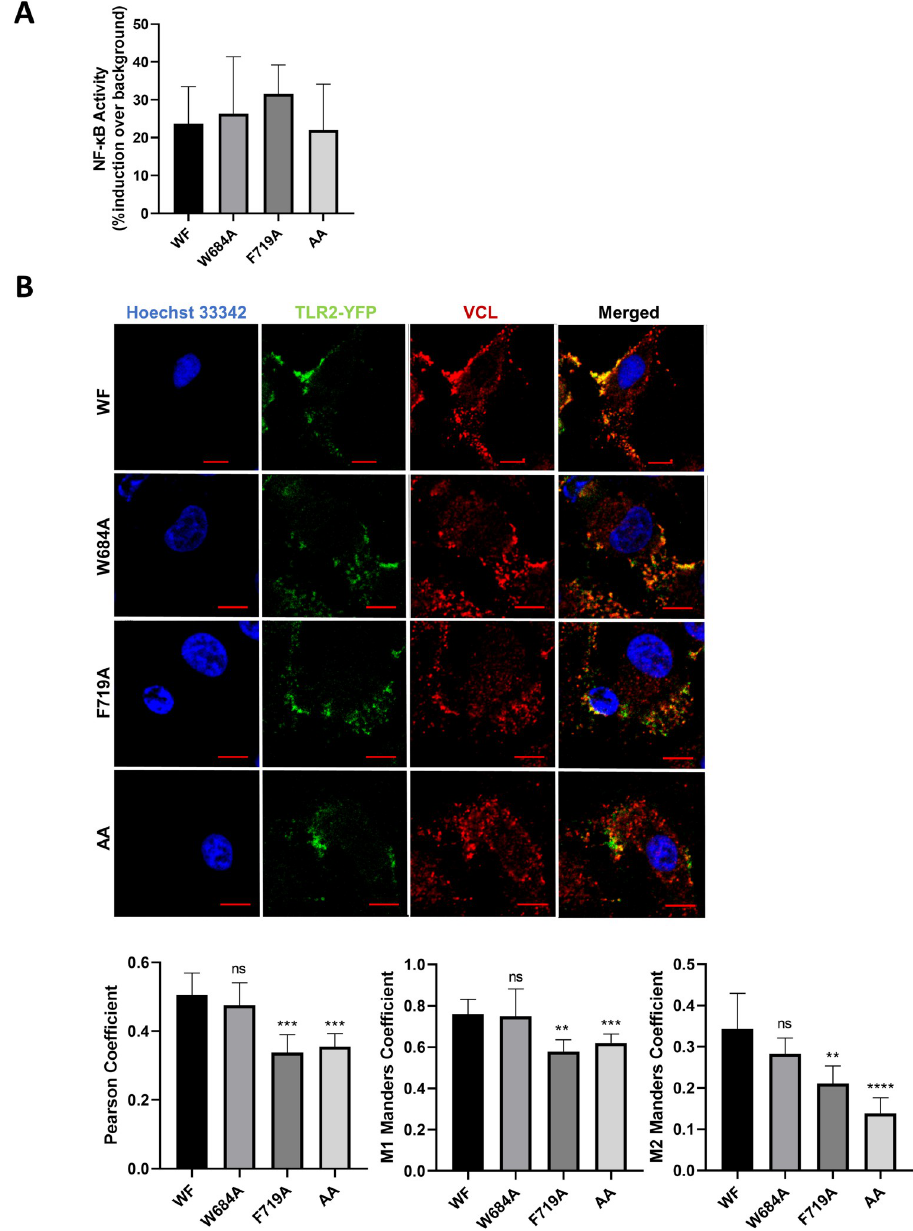
Fig 3. Site directed mutagenesis validates TLR2 residues involved in TLR2-VCL interaction. (A) NF- κ B reporter- HEK293 cells were transfected with native TLR2 (W684/F719), or each of the TLR2 mutants W684A, F719A, or W684A/F719A together with TLR1 and MyD88, and then cells were stimulated with PAM (100ng/mL) for 4 h. Cells were lysed and NF-kB activation was measured by luciferase activity. Percent NF-kB induction is shown relative to luciferase values of control cells transfected in an identical manner but not activated with PAM. Data represent mean values of three independent experiments. (B) HeLa cells were transfected with YFP-fused native (WF) TLR2, or W684A, F719A, or AA TLR2 mutants (green). Cells were fixed and stained for VCL (red) and nuclei were stained with Hoechst (blue). Images were captured using a NIKON confocal microscope at 60X magnification. TLR2-VCL co- localization was analyzed using JACoP/ImageJ analysis software. Data are representative of five independent experiments. (ns: non-significant; ** P � 0.01; *** P � 0.001; **** P � 0.0001).